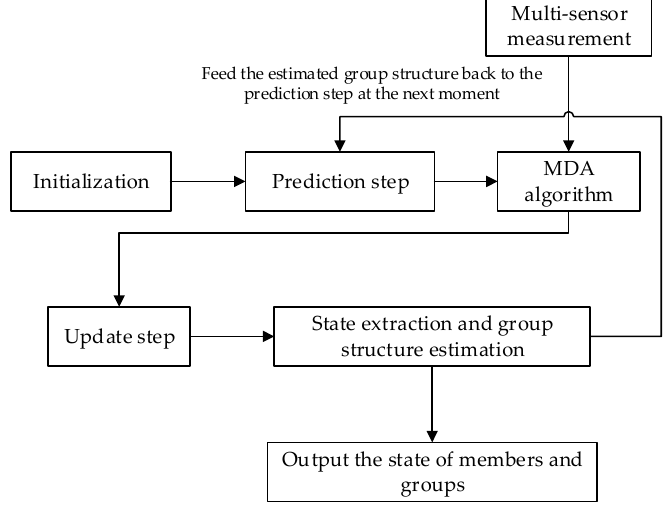
Figure 3. The filtering flowchart of the proposed method.